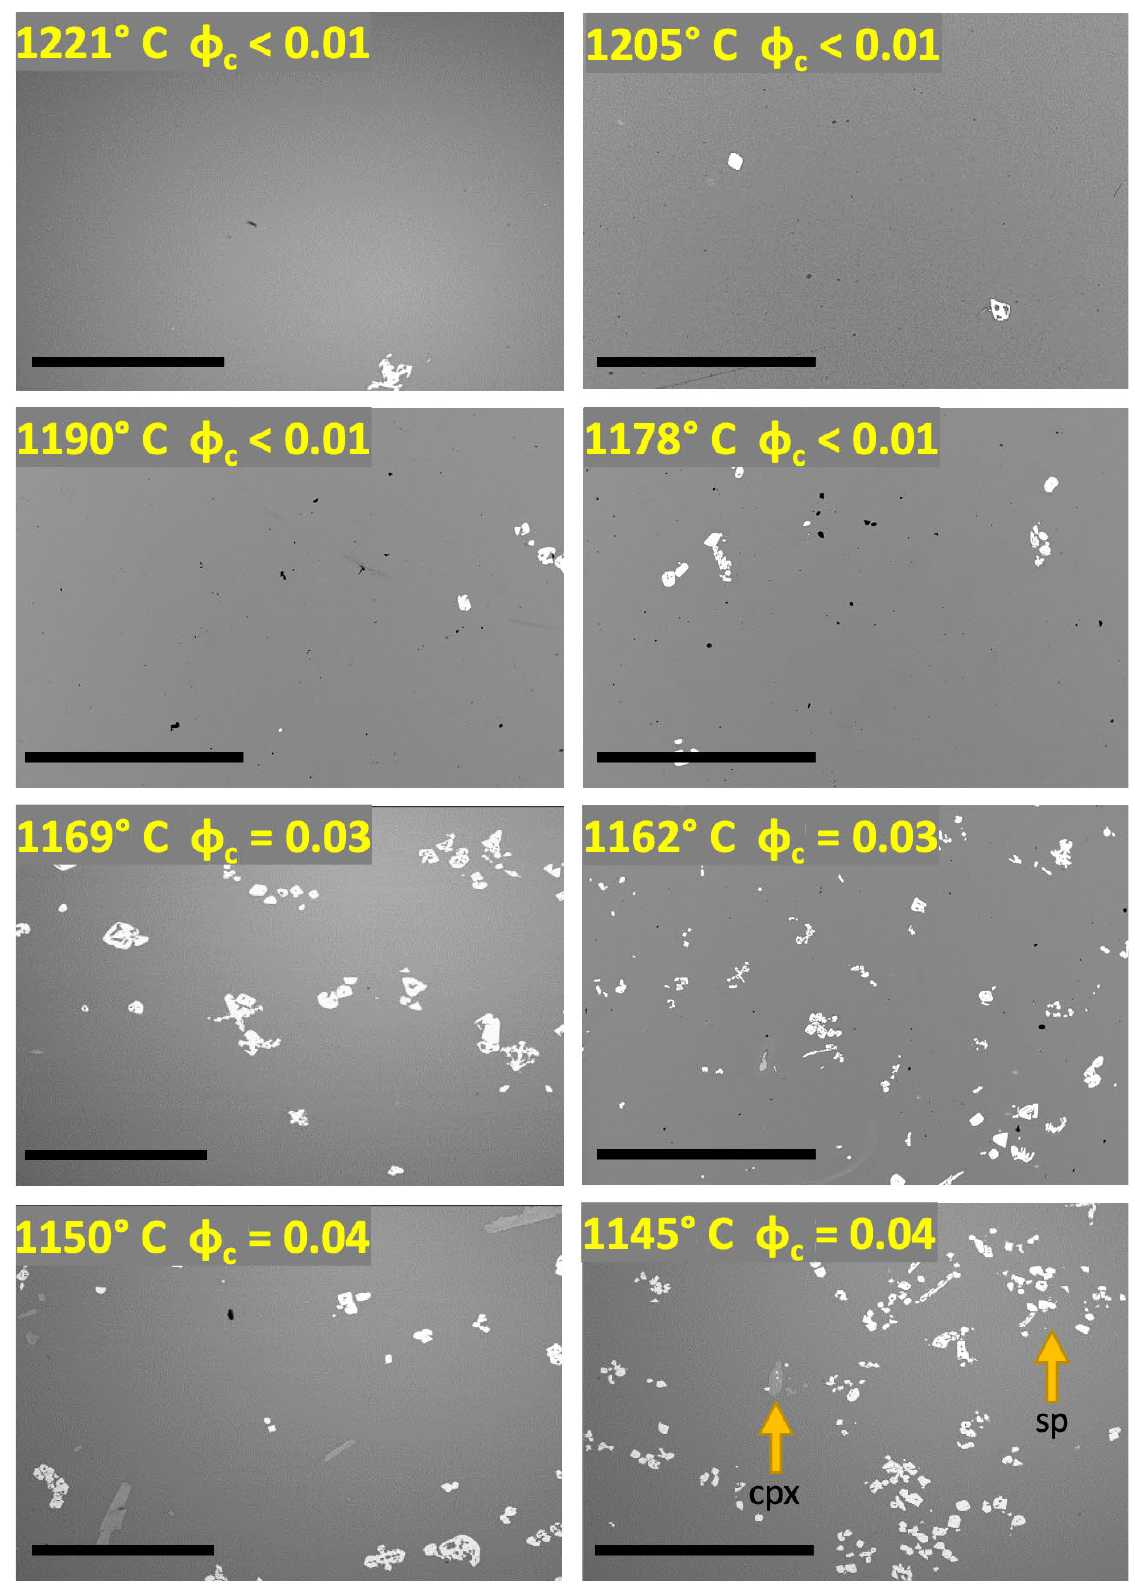
Figure 3: Backscattered electron images of each subliquidus experiment for Nyiragongo (NYI-2002). The black scale bar in each image is 500 µm. Crystal fraction uncertainty is roughly ± 0.02 (see Table 2). White crystals are spinels (sp) and light gray crystals are clinopyroxene